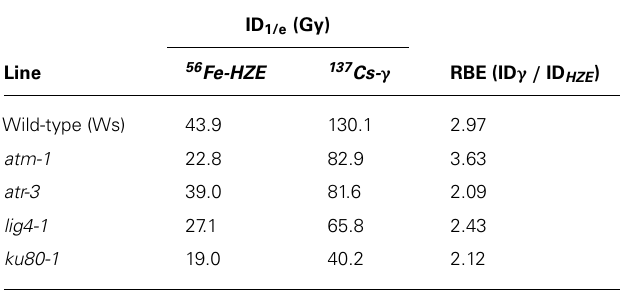
Table 1 | Relative biological effectiveness of HZE versus gamma radiation with respect to root